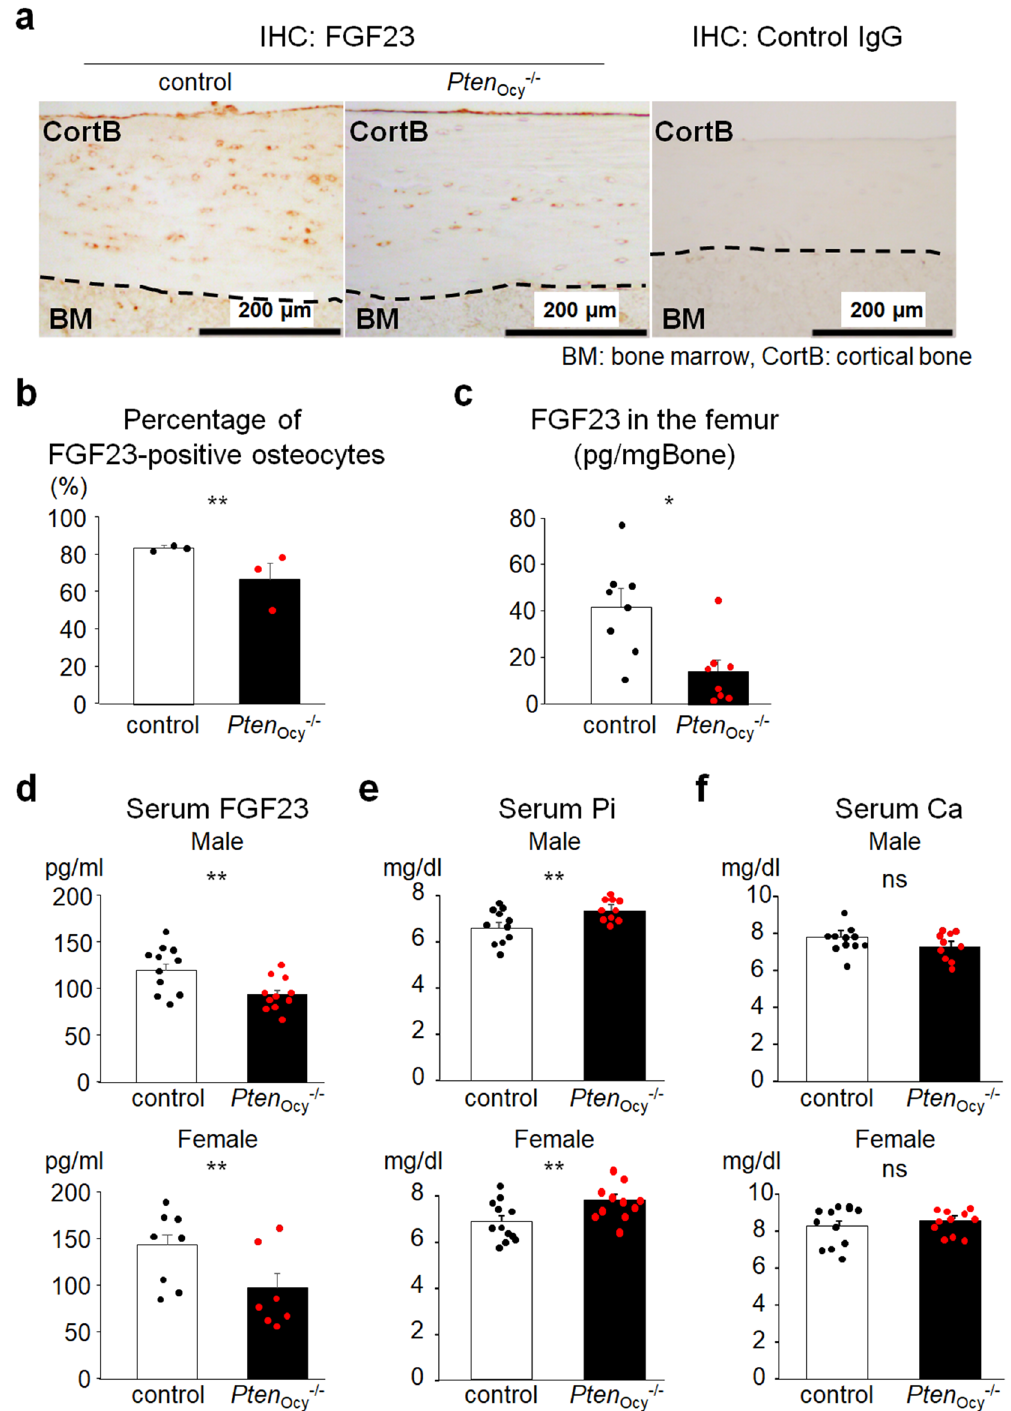
Figure 2. Decreased intact FGF23 levels in Pten Ocy−/− mice. ( a ) and ( b ) An immunohistochemical analysis of FGF23 in the femur was performed on 16-week-old male mice. A representative image of three independent experiments is shown ( a ). The percentage of FGF23-positive osteocytes over total osteocytes was counted (N = 3) ( b ). ( c ) The bone extracts of the femur were prepared from 16-week-old male mice and intact FGF23 concentration was measured (N = 8). ( d–f ) Serum levels of intact FGF23 (male: N = 11, female: N = 7–8) ( d ), Pi (male: N = 10–11, female: N = 11–13) ( e ), and Ca (male: N = 10–11, female: N = 11–13) ( f ) were measured in 16-week-old mice. Statistical analysis was performed by Mann–Whitney U test. * p < 0.01; ** p < 0.05, ns: not significantly